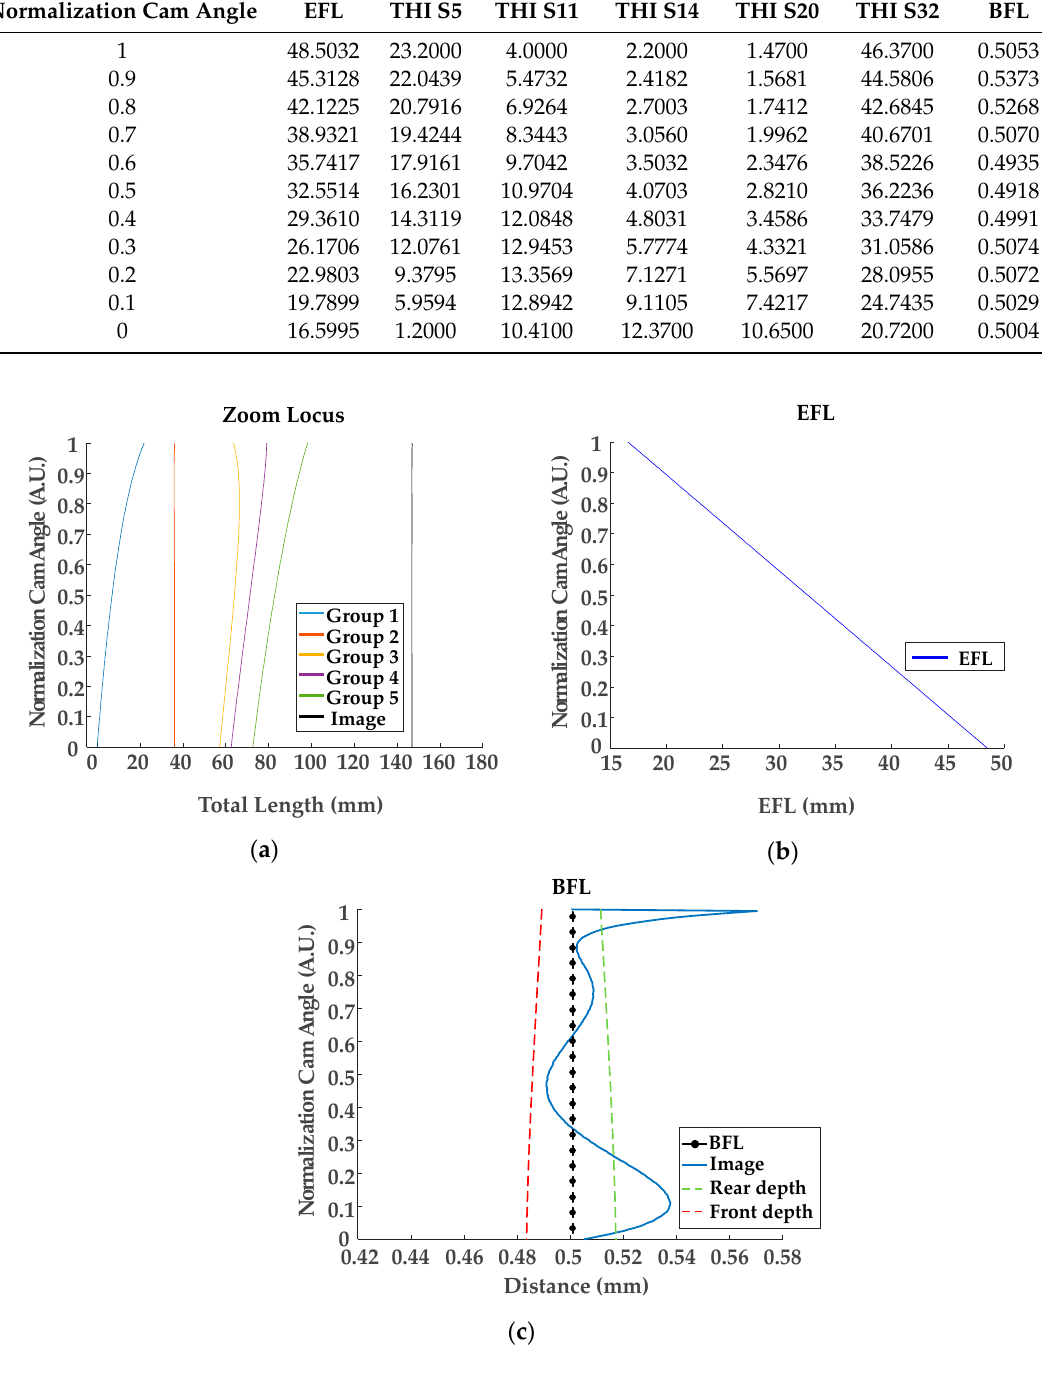
Table 5. Linearization of EFL using the Padé approximation.